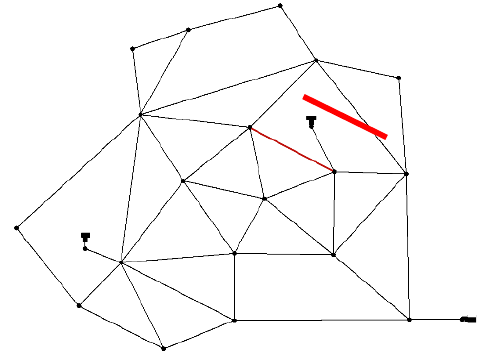
Figure 1. Anytown (two tanks and one pumping station).